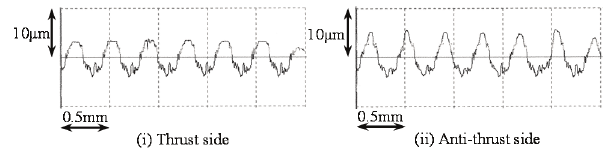
Fig. 4. Experimental piston